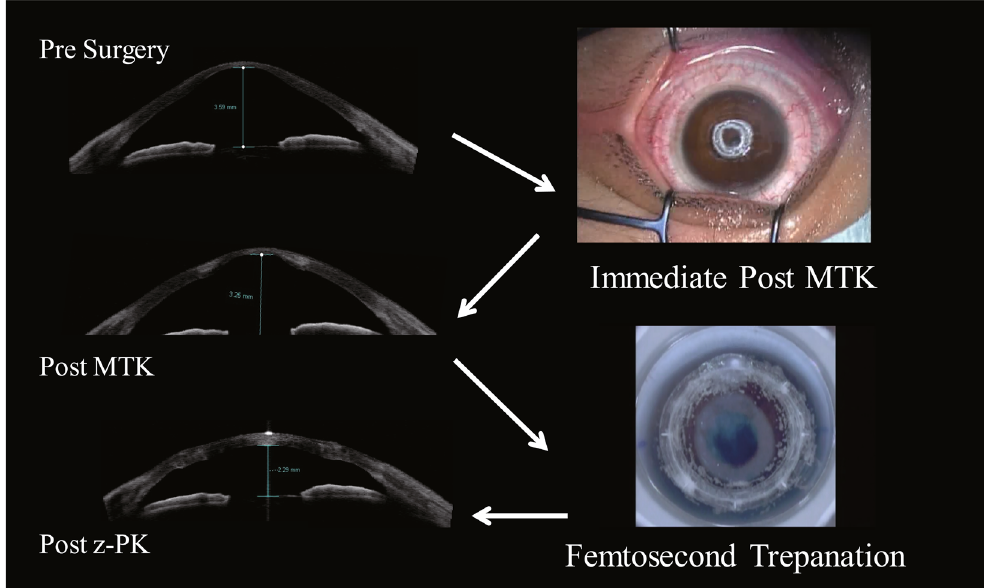
Figure 2. Microwave thermokeratoplasty (MTK) and z-PK images. First, MTK was performed to reduce the prominence of the keratoconus, followed by z-PK 2- to 4-weeks later.